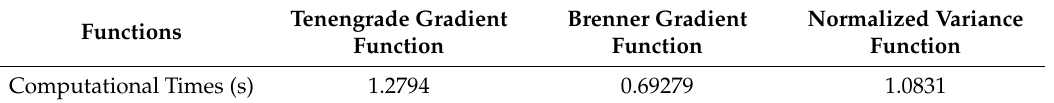
Table 2. Computational time for three selected focus functions.